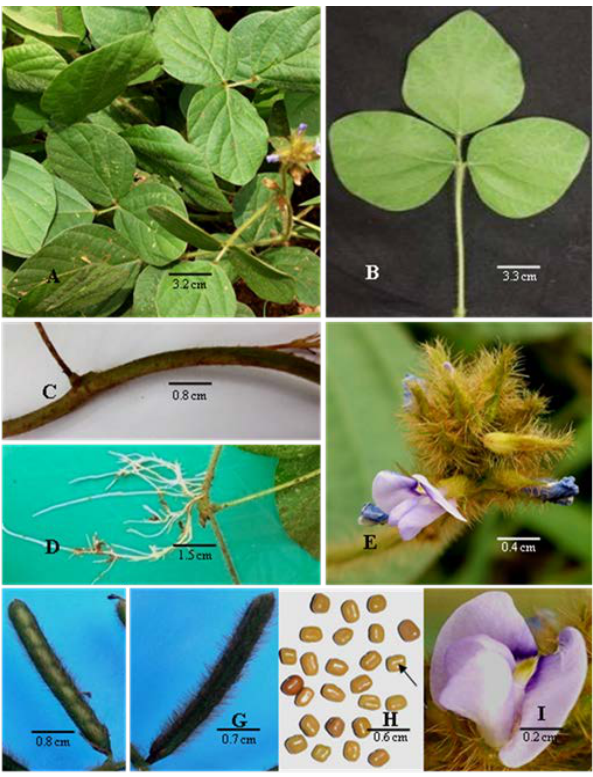
Fig. 5. Morphology of Calopogonium mucunoides Desv. A. Habit (herbaceous creeper), B. Leaf, C. Stem, D. Stem (rooting at node), E. Inflorescence (axillary cluster), F. Fruit (fresh), G. Fruit (showing hairs), H. Seeds (arrow points at depression), I. Flower